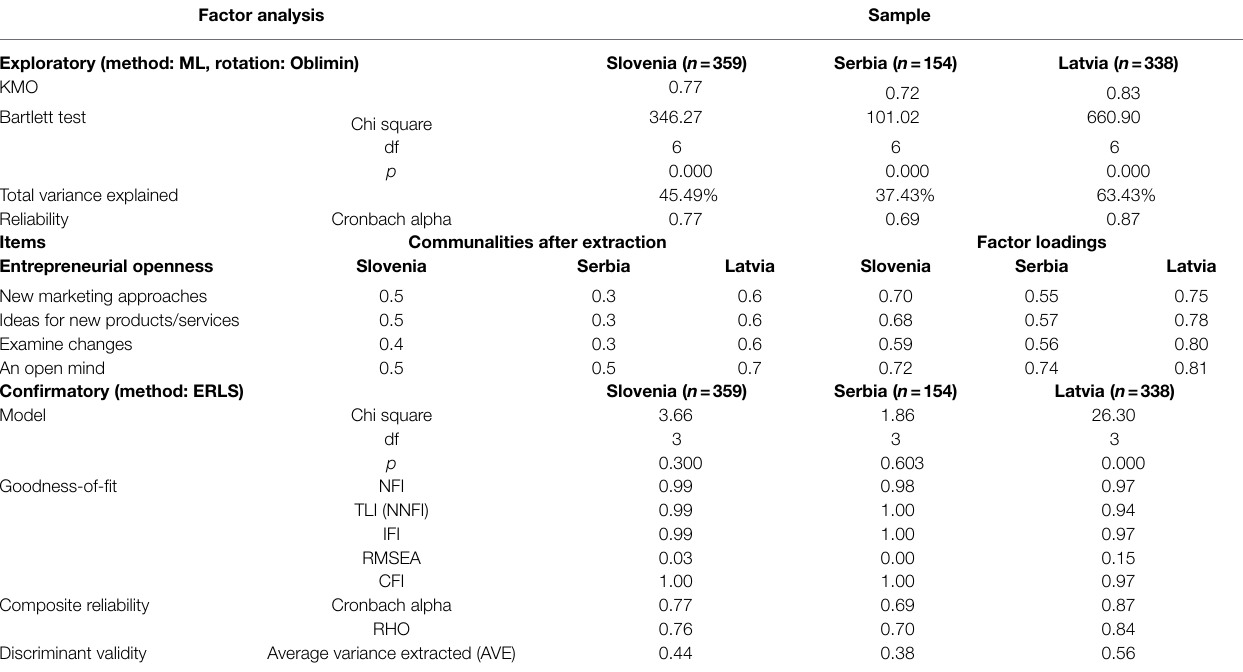
TABLE 2 | The entrepreneurial openness construct—factor analysis and reliability